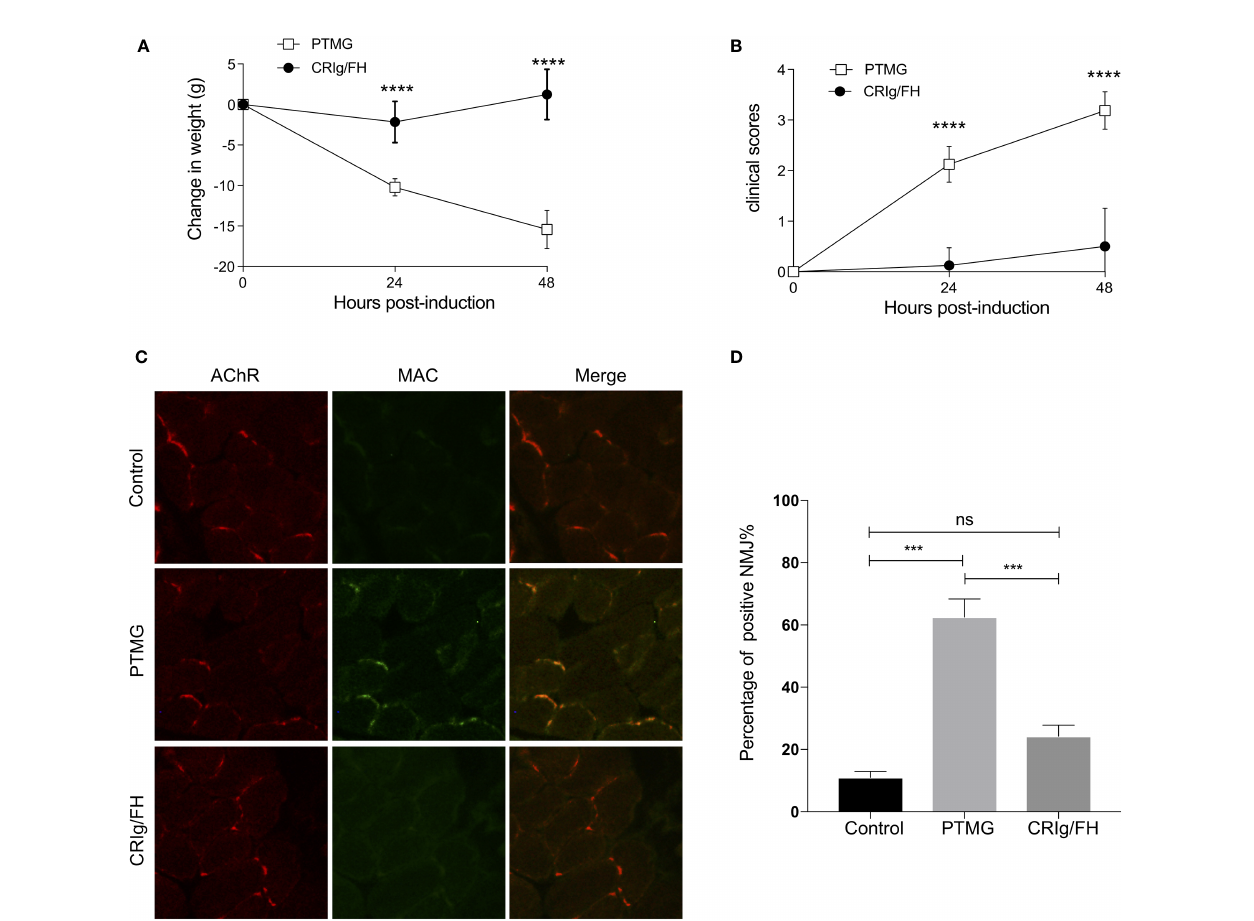
FIGURE 2 | CRIg/FH prevents PTMG development in rats by restraining complement-mediated destruction of NMJs. (A, B) CRIg/FH ameliorates PTMG clinical outcomes potently. CRIg/FH treatment was administered 2 h before PTMG induction. The weight loss (A) and clinical score (B) were measured at 24 and 48 h after PTMG induction, respectively. Data are presented as mean ± SD; n = 6/group; **** p < 0.0001; two-way ANOVA with Sidak ’ s multiple comparison test. (C, D) CRIg/ FH prevents MAC deposition on NMJs of PTMG rats. Diaphragm sections from control, PTMG, and CRIg/FH-treated rats were stained with anti-MAC (C5b-9n) antibody and detected with Alexa-488-labeled anti-rabbit IgG (green). Alexa-555-labeled bungarotoxin was used to identify AChR in NMJs (red). Minimum four sections with 5 – 15 NMJs from each diaphragm were quanti fi ed. Representative images are shown in (C) and quantitative data (D) are presented as the percentage of NMJs (%) with detected complement deposits (mean ± SEM). Comparisons of means were performed using one-way ANOVA with Tukey ’ s multiple comparison test (ns, not signi fi cant, *** p < 0.001). Results are representatives of three independent